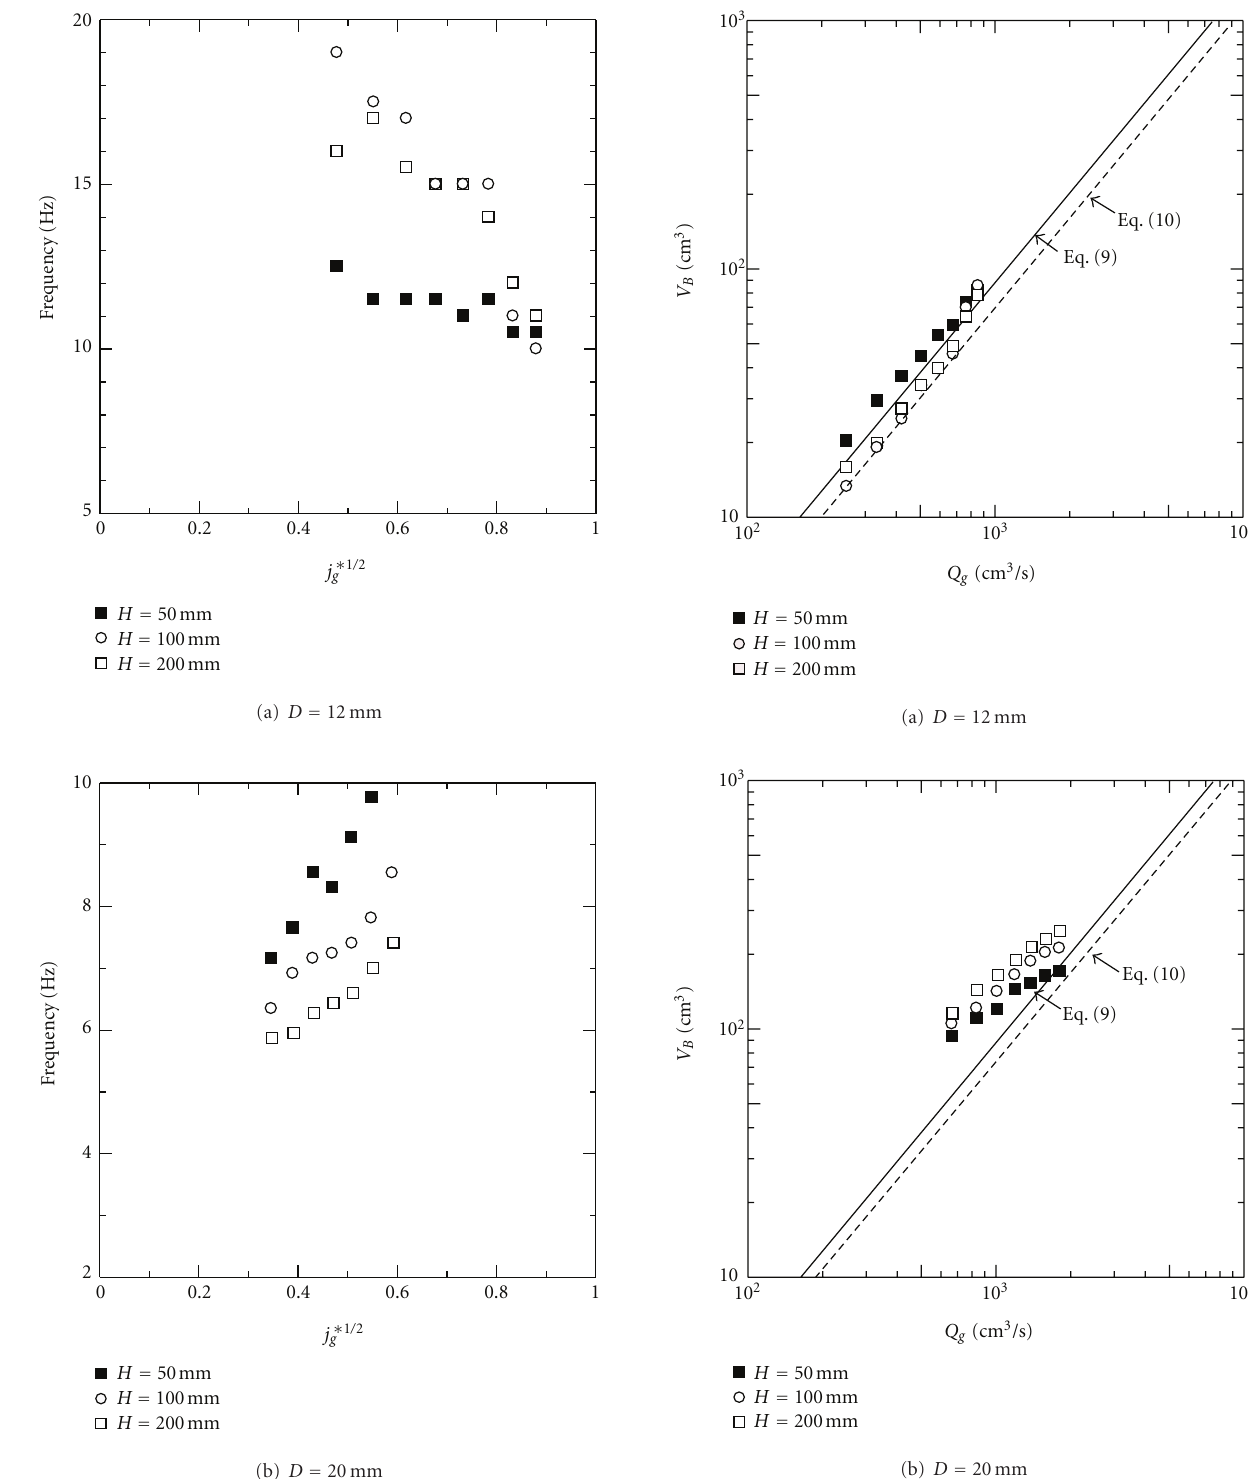
Figure 16: Comparison of present experimental data with proposed correlations for bubble